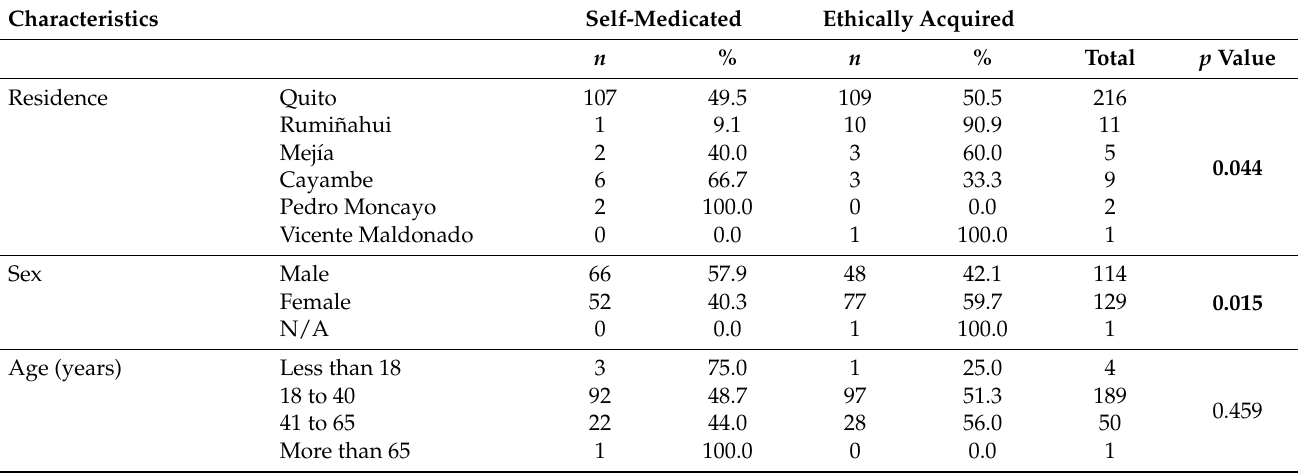
Table 3. Self-medication distributions according to the participant’s